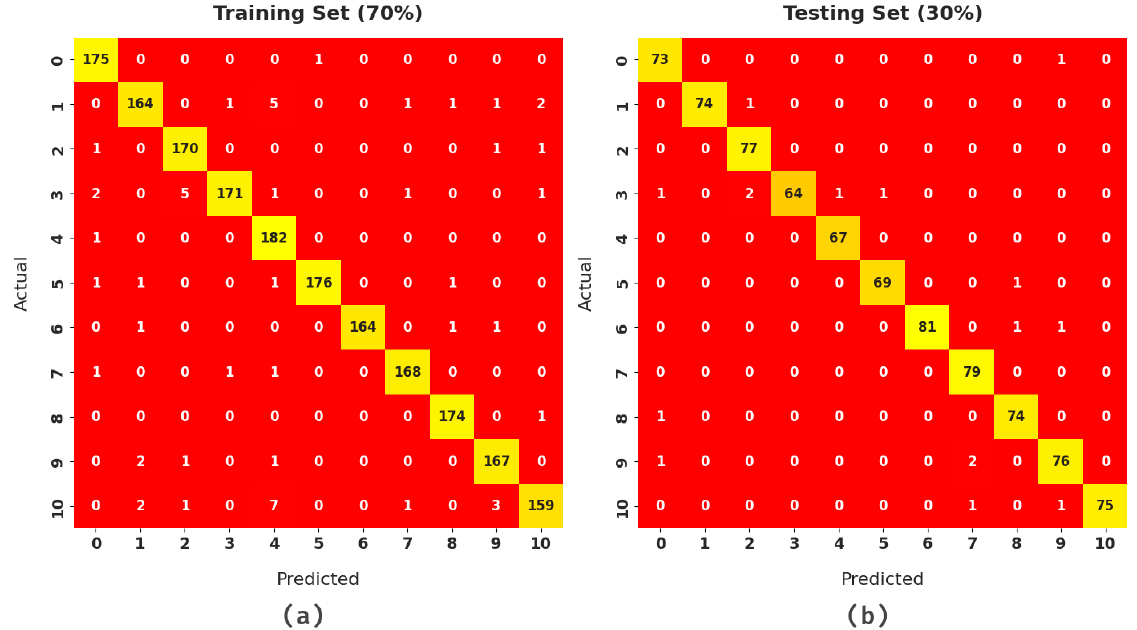
Figure 4. Confusion matrix of SFODLD-SAC technique. ( a ) The training set (TRS) and ( b ) the testing set (TSS). Table 3. Result analysis of SFODLD-SAC technique with distinct measures on 70% of